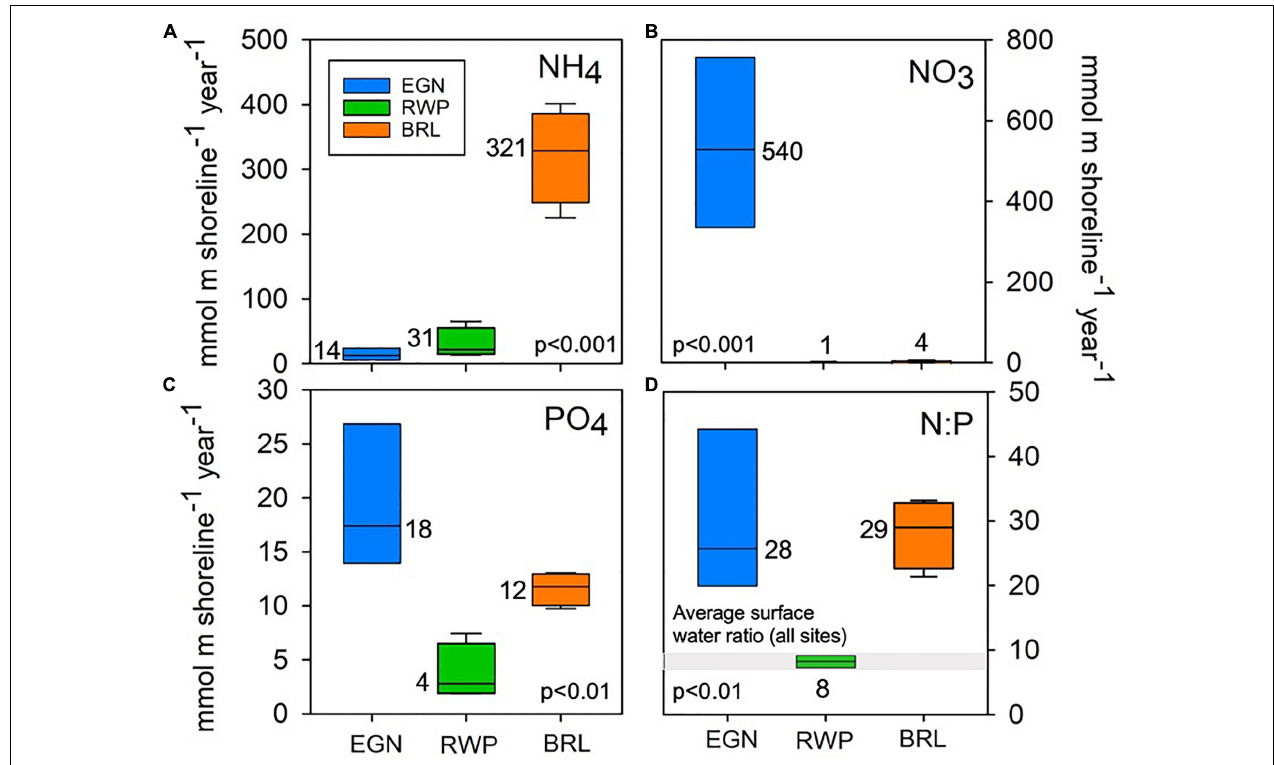
FIGURE 7 | Box plots of the distribution of nutrient loads over the four sampling campaigns including (A) NH 4 , (B) NO 3 , (C) PO 4 , and (D) N:P. The average value is given adjacent to each box plot ( n = 4 in all cases). The range in N:P ratios of lagoon surface water over all four sampling periods for all sites is given by the gray bar in panel (D) ( n =